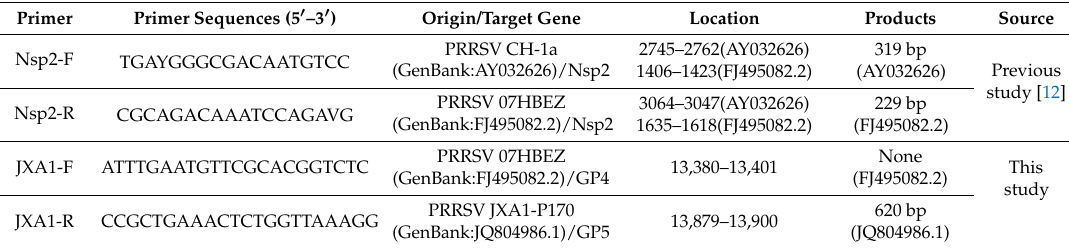
Table 1. The primer sequences for multiplex